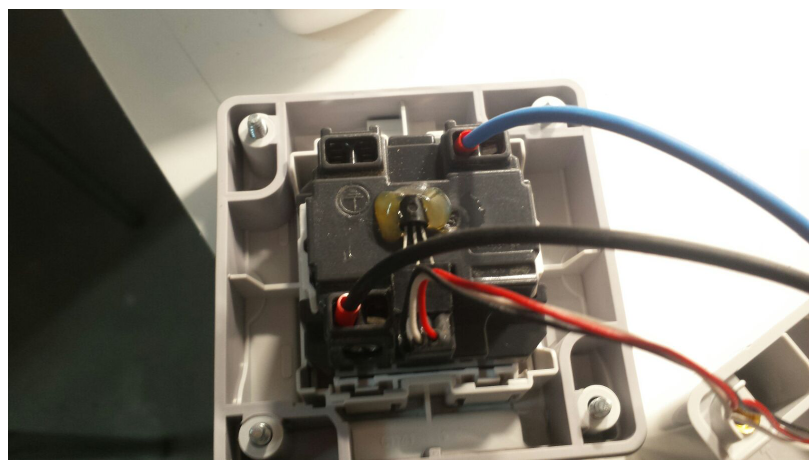
Figure 7. Temperature sensor glued on the back of a power